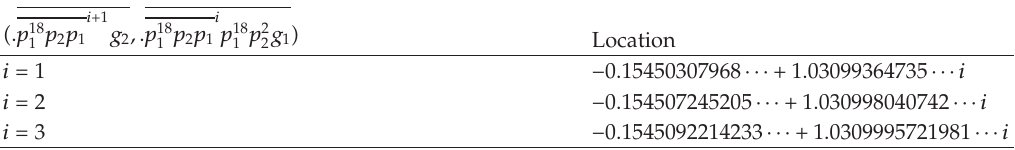
Table 7: Location of canonical 20.tuple-spiral